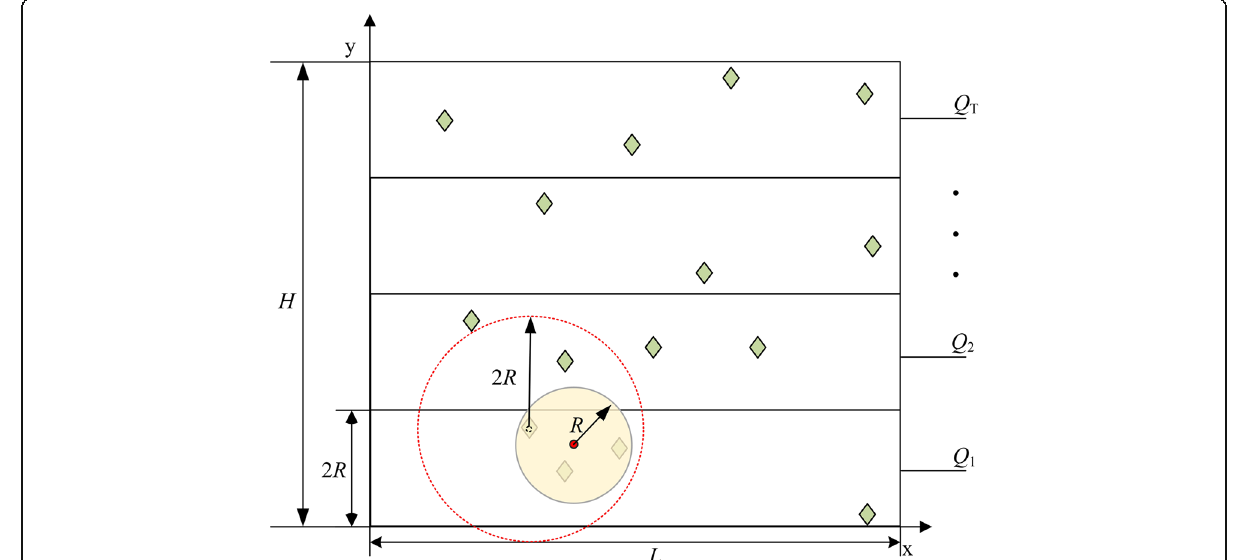
Fig. 2 Diagram of the procedure of CCG